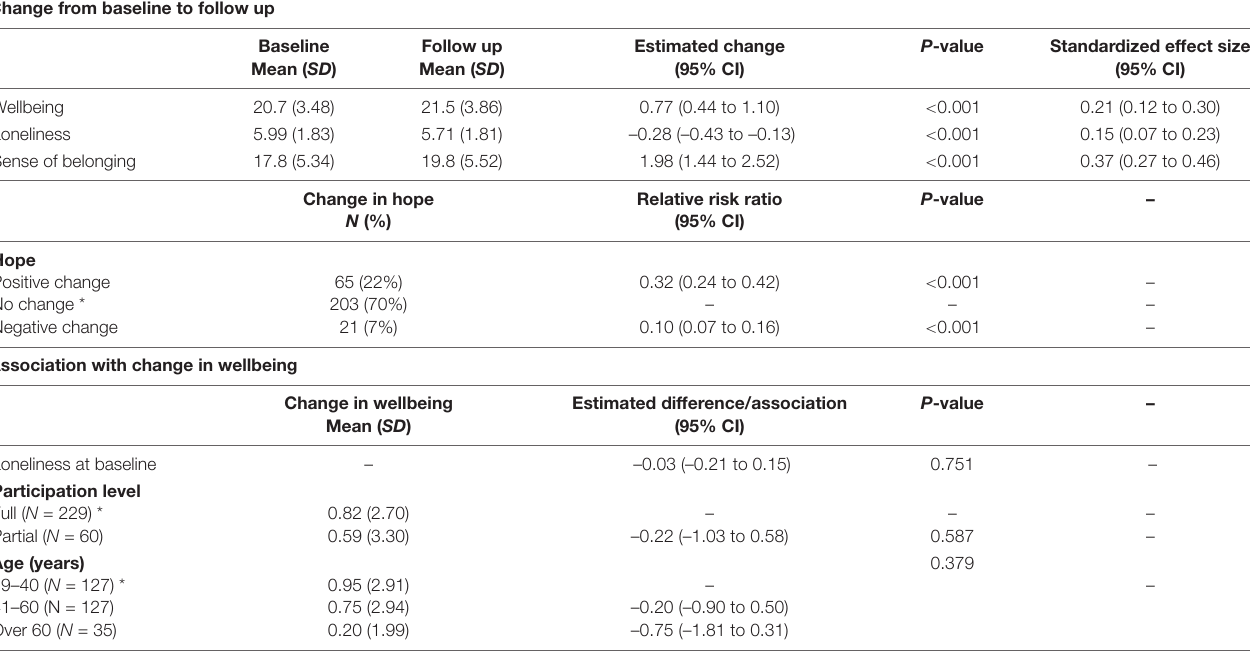
TABLE 3 | Estimated change in wellbeing, loneliness, belonging and hope and associations with change in wellbeing. Change from baseline to follow up